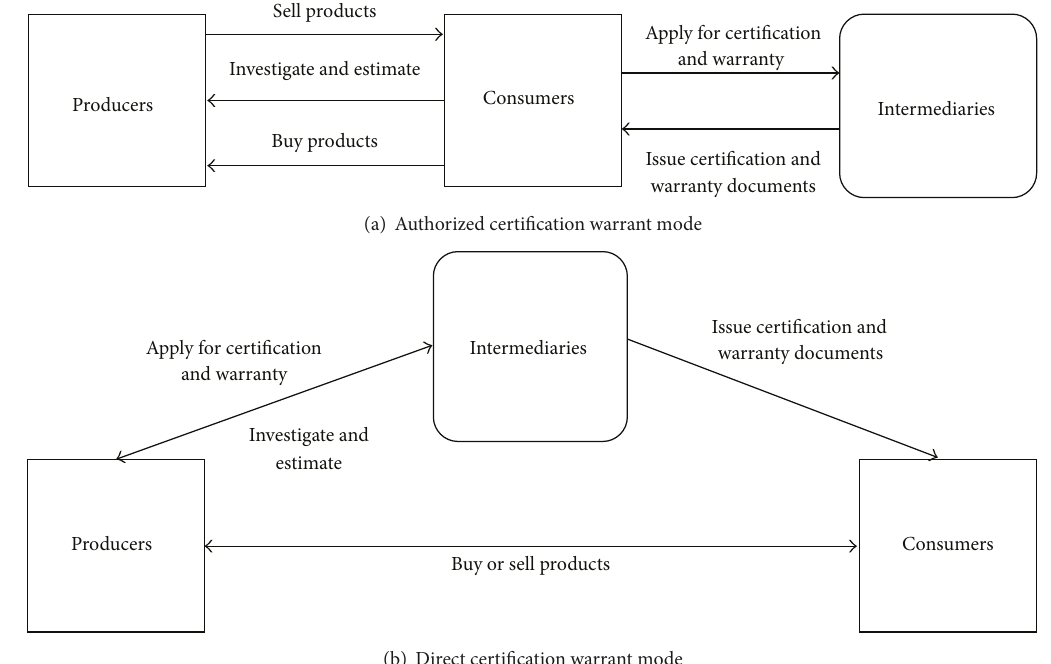
Figure 2: The certification warrant mode of